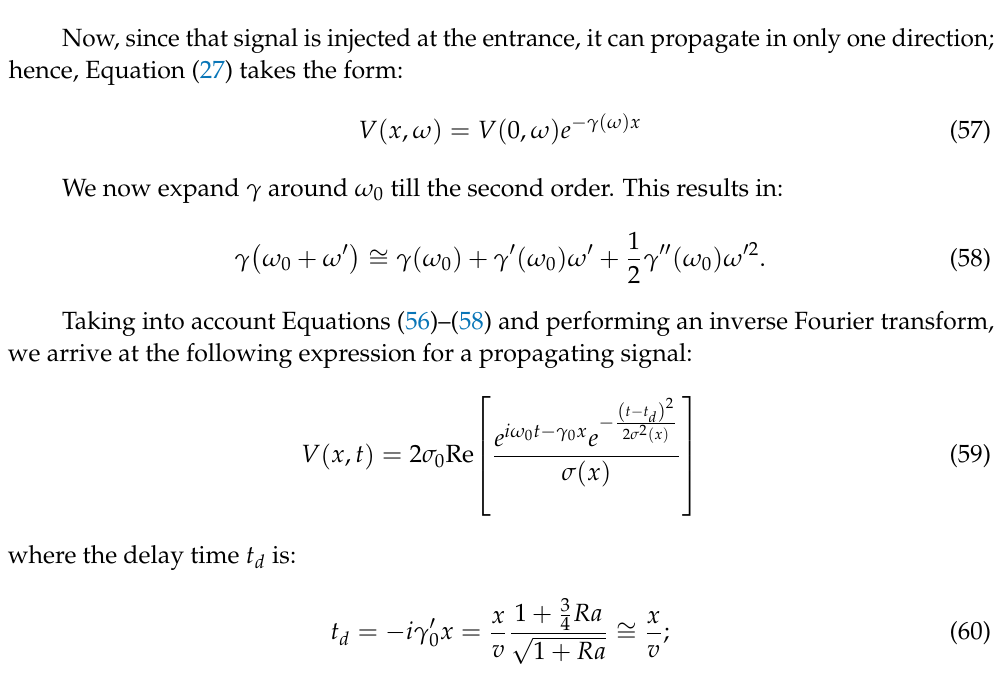
Figure 15. The entrance voltage signal in the frequency